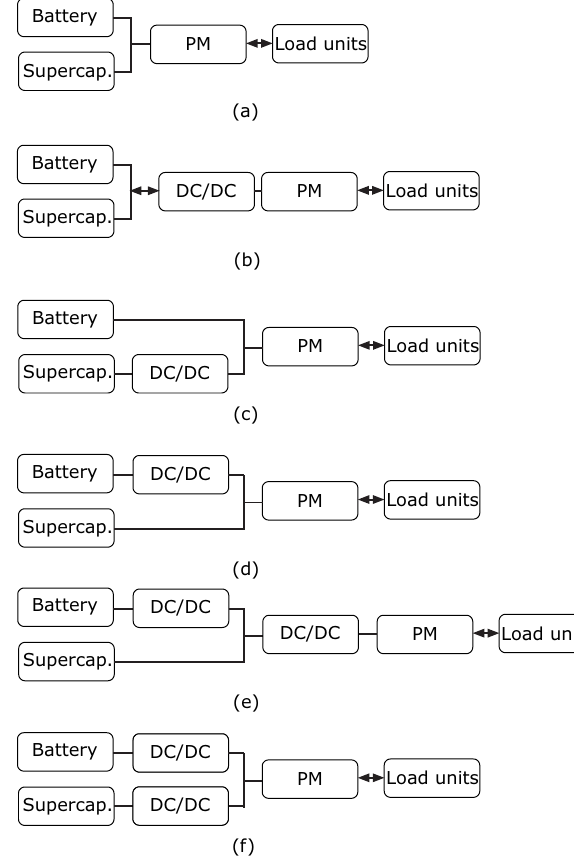
Figure 1. Typical topologies in electrical powertrains: ( a ) passive; ( b ) parallel semi-active; ( c ) capacitor semi-active; ( d ) battery semi-active; ( e ) series active; ( f ) parallel active (PM refers to power management, supercap. refers to